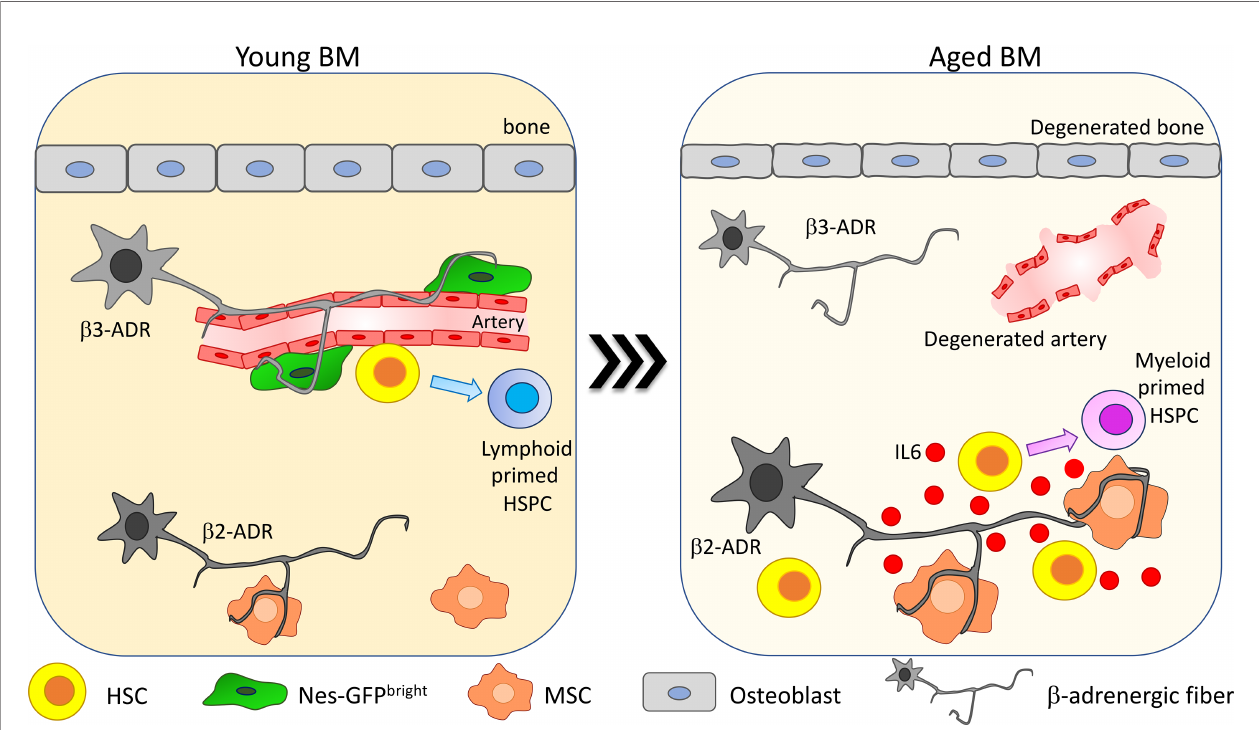
FIGURE 3 | b -Adrenergic signaling alteration upon aging. b -Adrenergic innervation is strongly altered upon aging (41, 75). In young mice b 3-adrenergic stimulation is predominant and promotes lymphoid differentiation while b 2-adrenergic stimulation is involved in regulating myeloid differentiation. Upon aging, b 2-adrenergic stimulation is increased and promotes MSC secretion of IL6, thus increasing HSC myeloid differentiation